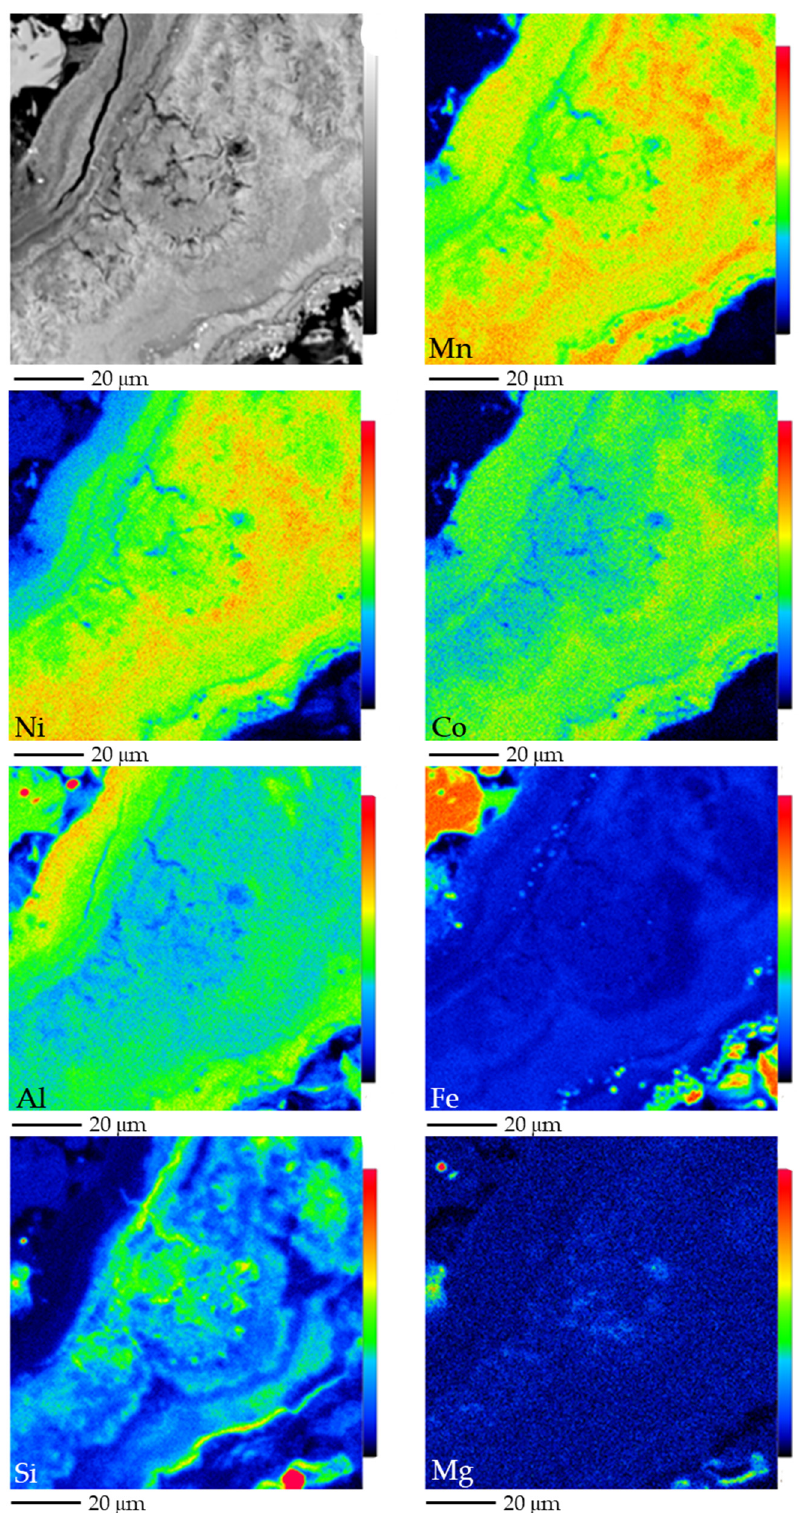
Figure 8. BSE photomicrograph (top left) and Mn, Ni, Co, Al, Fe, Si and Mg X-ray elemental maps obtained by EMPA of banded colloform aggregates from Loma Caribe. Colour scale from black to red indicates increasing element content.